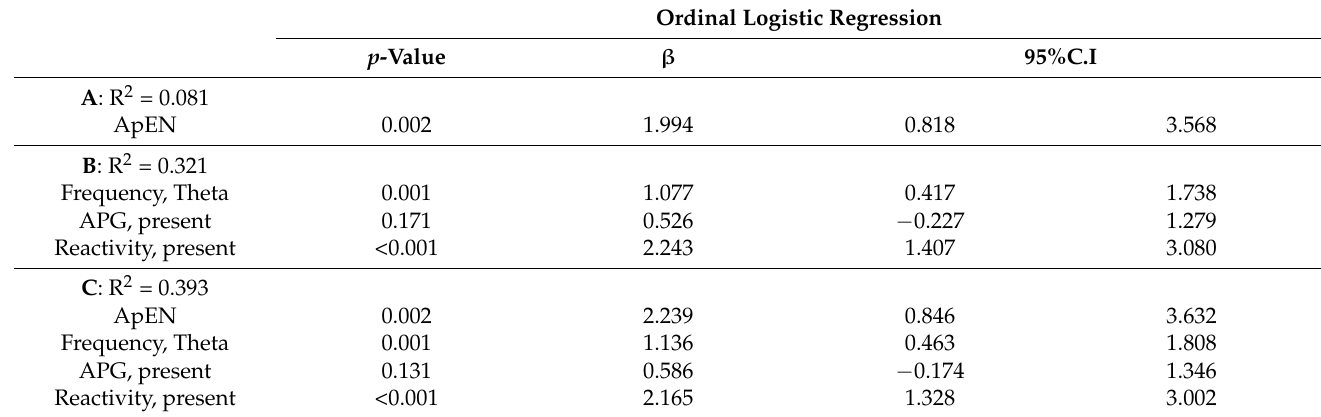
Table 3. Ordinal regression results for only ApEN ( A ), EEG descriptors ( B ) and a combination of the two ( C ).